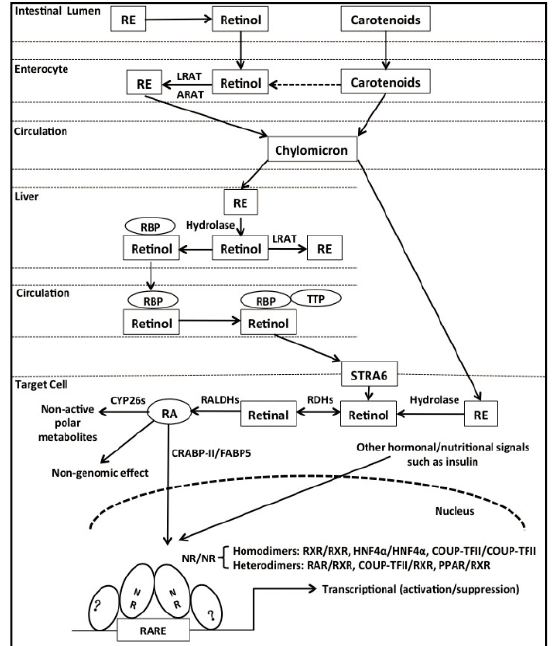
Figure 1. Metabolism of vitamin A (VA) and retinoic acid (RA) signaling. In the small intestine, retinyl esters (REs) are metabolized to retinol, which is converted to REs in enterocytes. REs and carotenoids are then incorporated into chylomicrons and exported into the circulation. The chylomicron remnants are taken up by the hepatocytes and REs are converted to retinol, which is either converted to REs for storage in stellate cells or bound to retinol-binding protein (RBP) for release into the circulation. In the bloodstream, holo-RBP associates with transthyretin (TTR) to form a holo-RBP-TTR complex to avoid